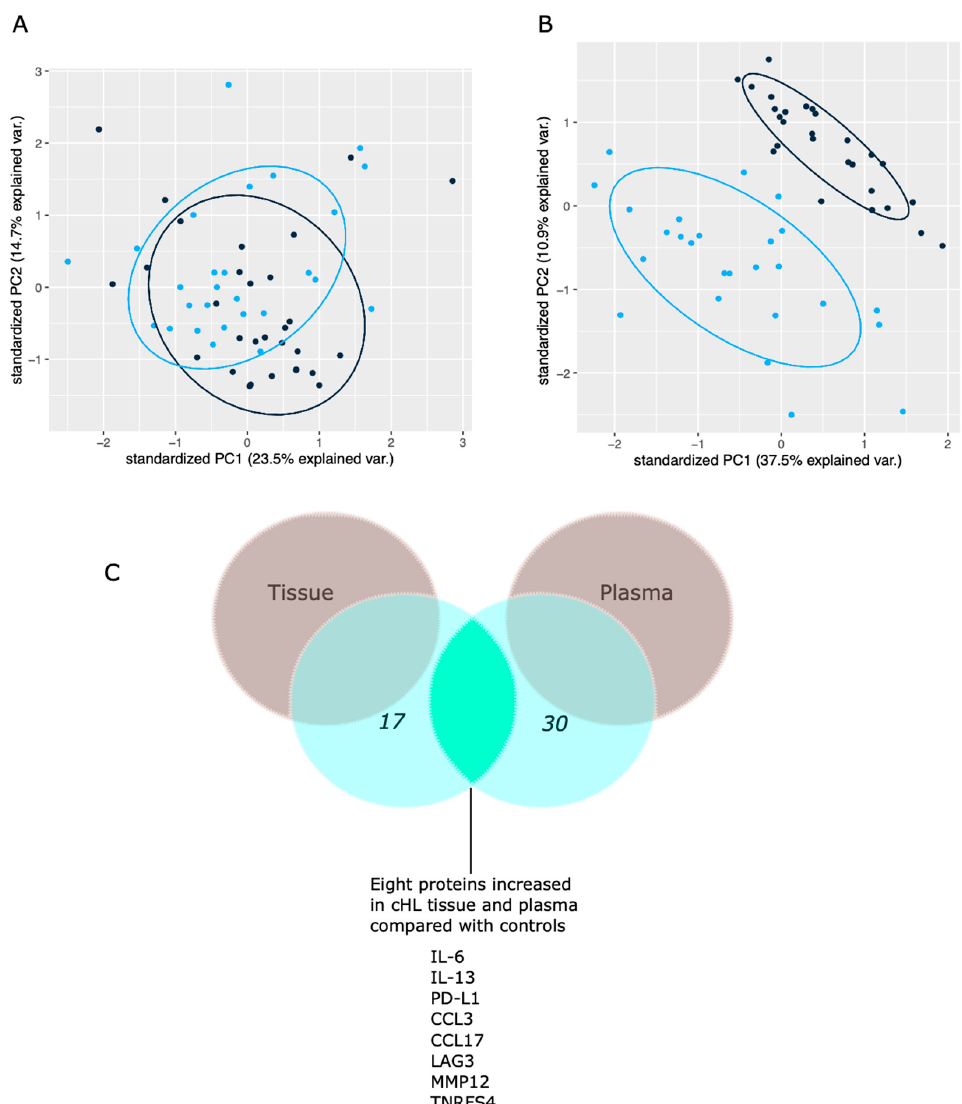
Figure 2. Principal component analysis (PCA) and Venn diagram for the proteome profile: ( A ) PCA plot for tissue. Dots demonstrate individual sample distribution of 27 cHL tumor tissues analyzed with PEA (blue) and corresponding control (black) lymph nodes, n = 30. ( B ) PCA plots for plasma. Dots demonstrate individual sample distribution of 26 cHL patients (blue) and controls (black), n = 27; a total of 92 proteins were included. PC = principal component. ( C ) Schematic Venn diagram showing the number of proteins with significantly higher levels in cHL cases than controls in both tissue and plasma after univariate analysis and adjusted analysis. Table 2. Proteins with significant differences in cHL tumor tissue versus control tissues.